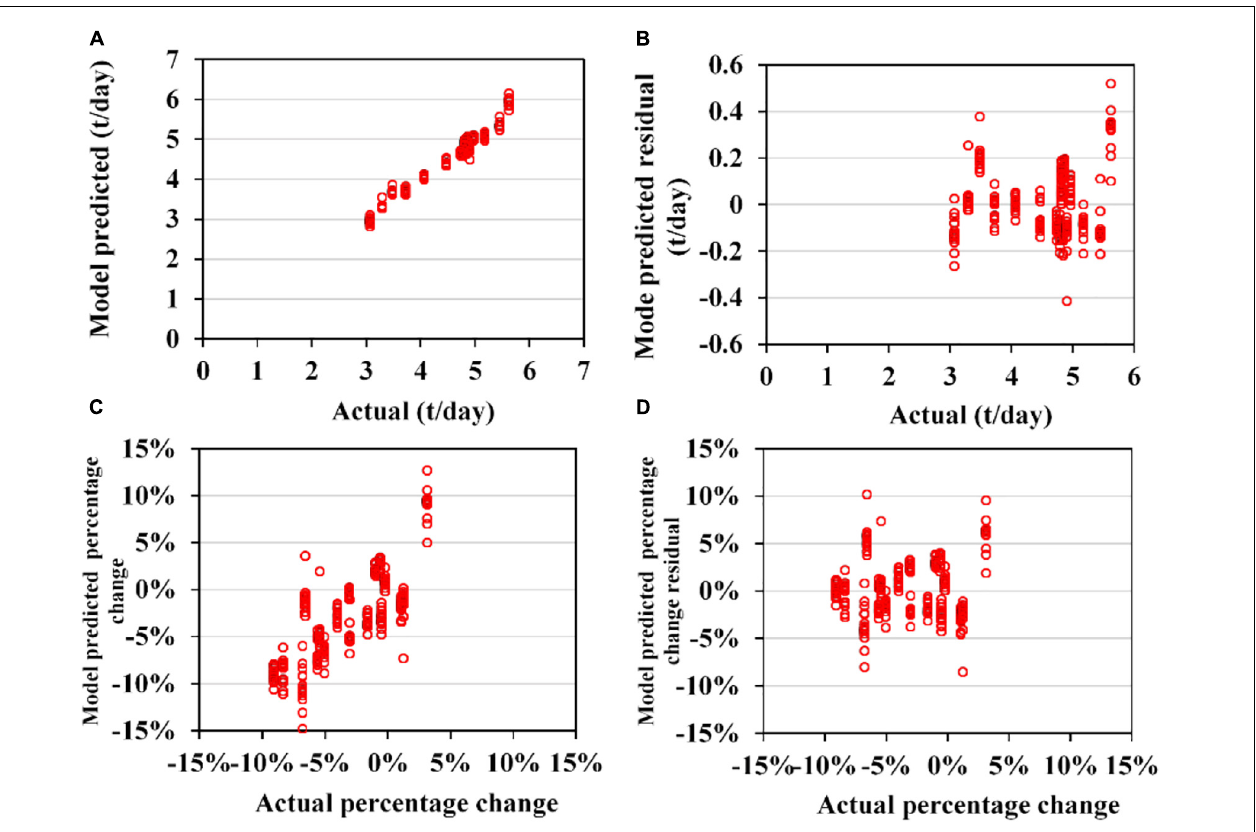
FIGURE 8 | Cross-validation results of 153 sub-models of generalized additive models (GAM) for the interannual abundance trend of Dosidicus gigas (TA). (A) Model-predicted and actual TA; (B) model-predicted residual and actual TA; (C) model-predicted and actual TA percentage change compared with the last year (except for 2003 in which it is compared with the year 2004); (D) the model predicted the residual and actual value for TA percentage change compared with the last